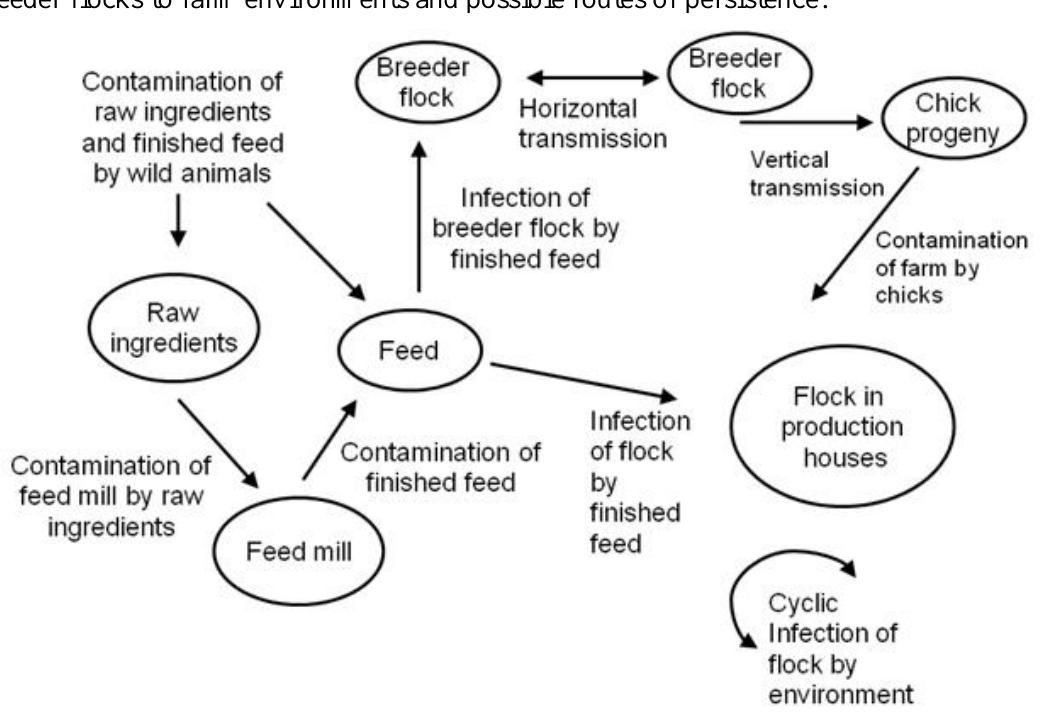
Figure 1. A diagram of the possible routes of dissemination of Salmonella from broiler breeder flocks to farm environments and possible routes of